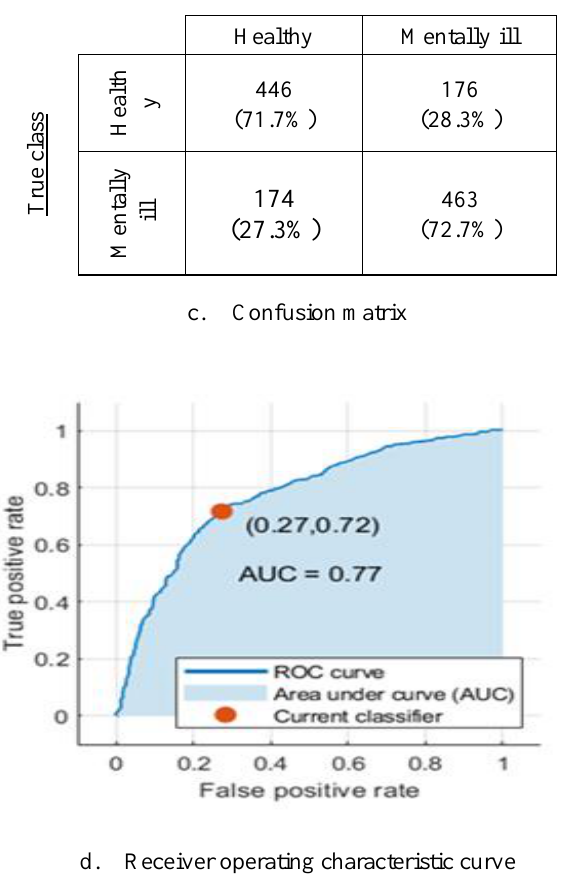
Fig. 4. SVM hyperparameter tuning for classification of MI based on